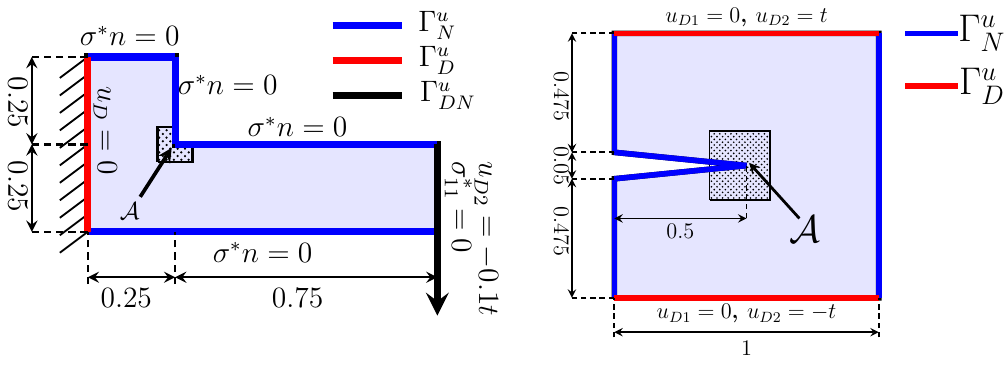
Figure 2. An L-shaped cantilever ( left ) and a cracked domain ( right ) with the subdomain A as an observation